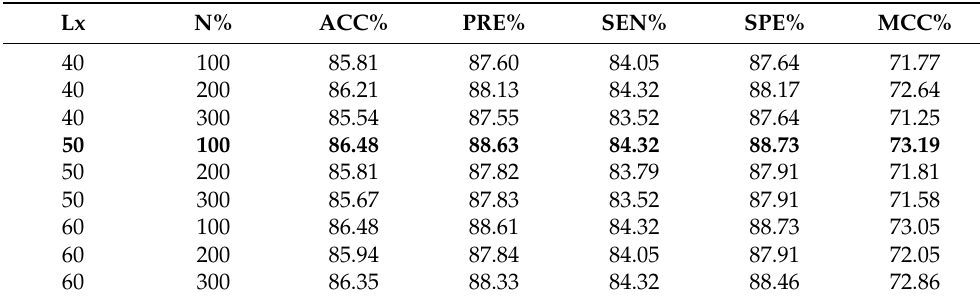
Table 1. Performance of ACP-ADA with parameters ‘Lx’ and ‘N’ on the ACP740 dataset along with performance metrics (the best metrics are shown in bold).